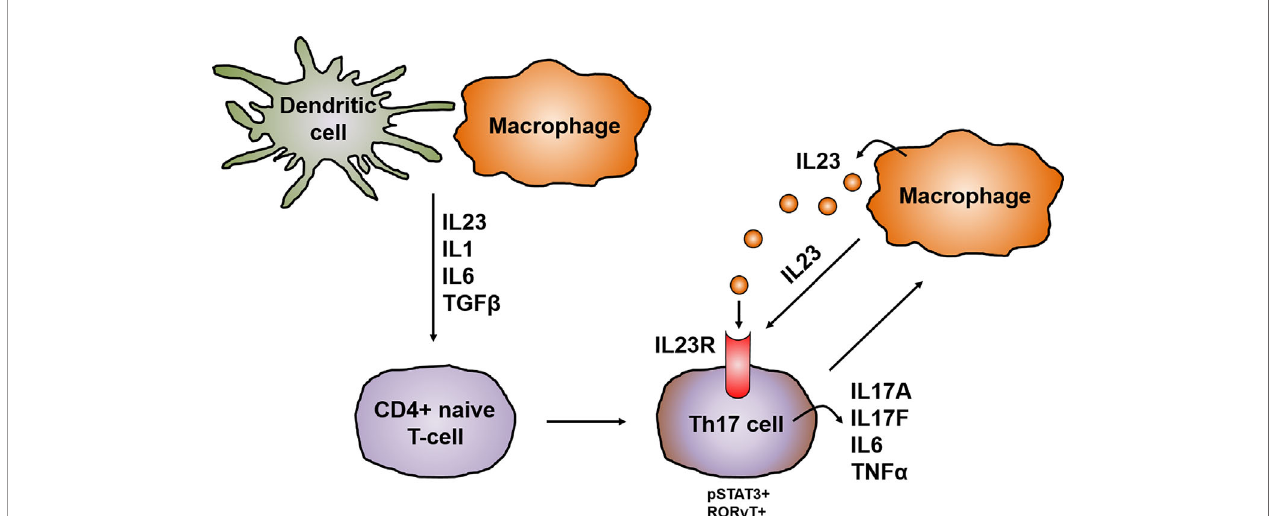
FIGURE 3 | IL23 in the development and activation of Th17 cells. In chronic in fl ammation, antigen-presenting cells like dendritic cells and macrophages are the main producers of IL23, which promotes together with other cytokines like IL1, IL6 and TGF b the development of IL17 producing pathogenic Th17 cells. The differentiation of Th17 cells is prompted by the synergistically working of STAT3 and ROR g t leading to the upregulation of the IL23R on Th17 cells and the release of other pro- in fl ammatory cytokines like IL17A, IL17F, IL6 or TNF a . This in turn leads to the production of IL23 mainly by macrophages. IL23 is on the one hand important for the maintenance and expansion of the Th17 lineage and in addition acts mainly on macrophages in an autocrine